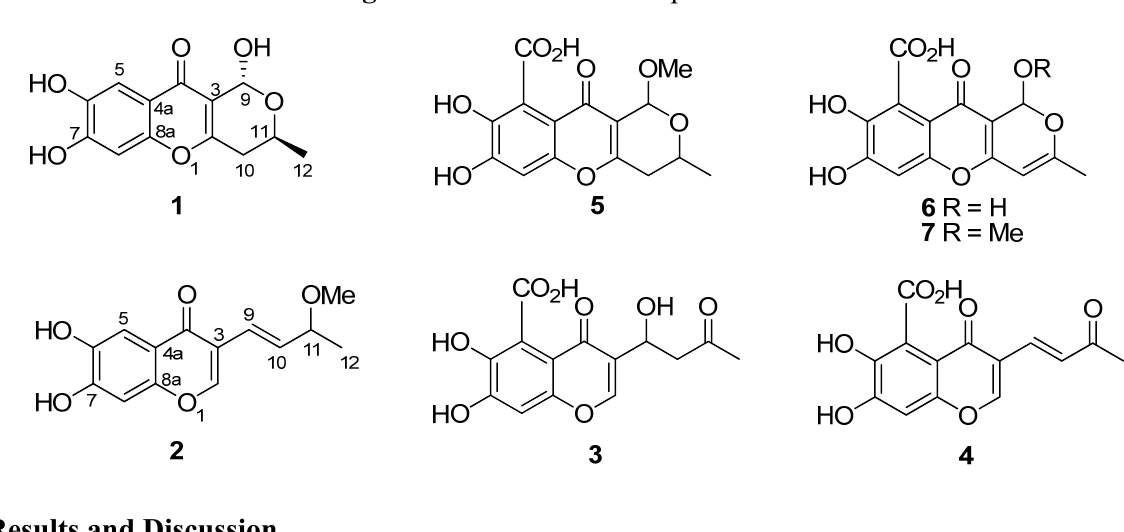
Figure 1. Structures of compounds 1 – 7